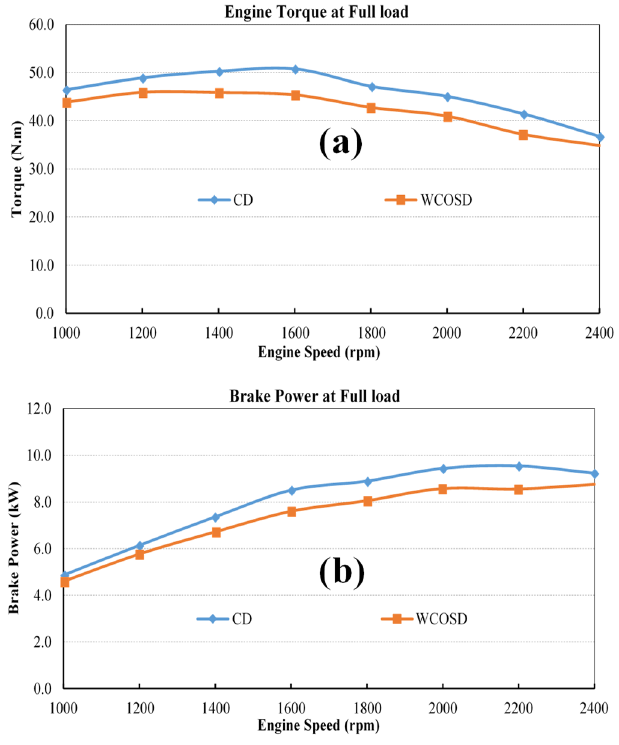
Figure 1. ( a ) engine torque and ( b ) engine brake power at full load conditions.